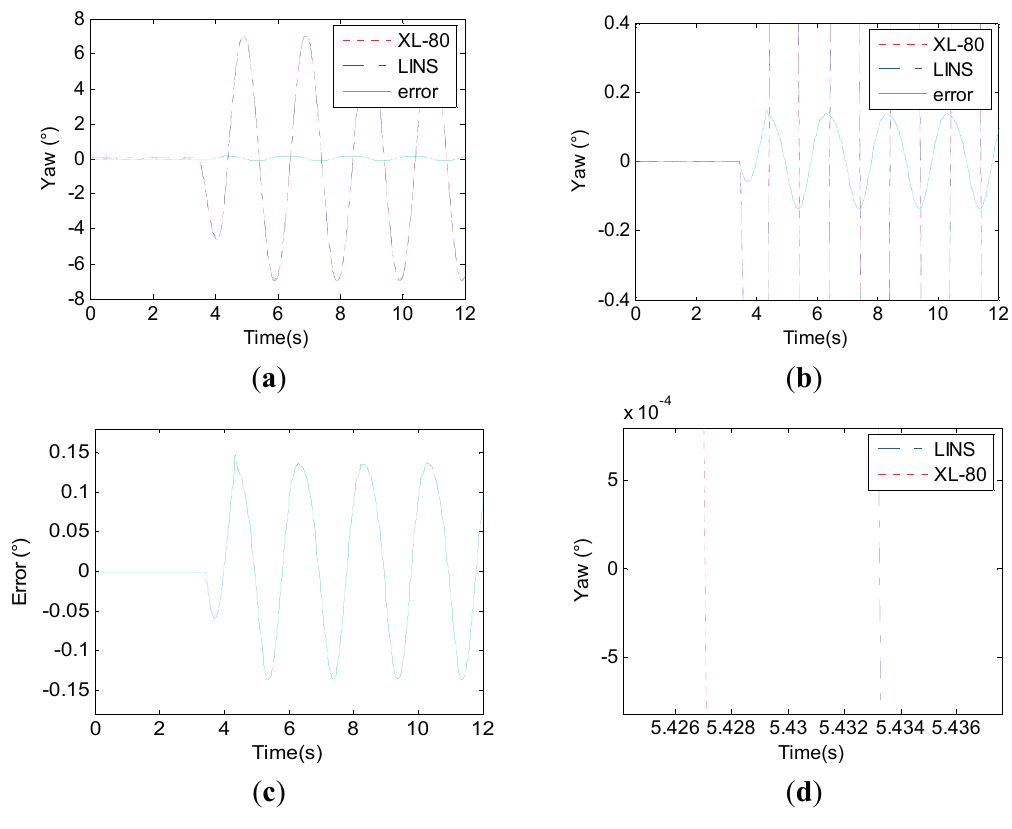
Figure 10. Wobbling test results without time delay synchronization. ( a ) First 12 s curve of wobbling test; ( b ) Phase of error lag turntable / 2 π ; ( c ) Error curve; ( d ) Phase relationship between table and